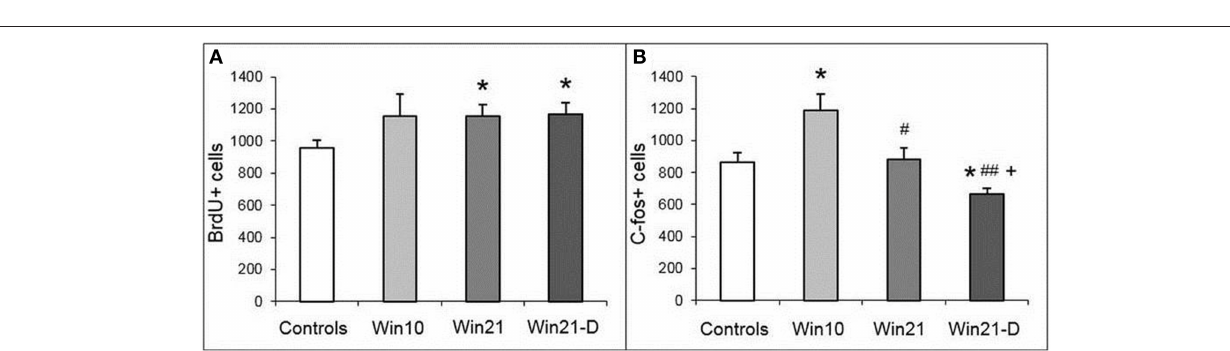
FIGURE 4 | BrdU-positive cells (A) and c-fos labeled cells (B) in the DG of male mice with different fighting experience. C57BL/Icg male mice: Win10, 10 day winners; Win21, 21 day winners; Win21-D, 21day winners after 2 weeks of fighting deprivation. * P < 0.05 vs. the controls; # P < 0.05 and ## P < 0.01 vs. Win10; + P < 0.05 vs. Win21; t